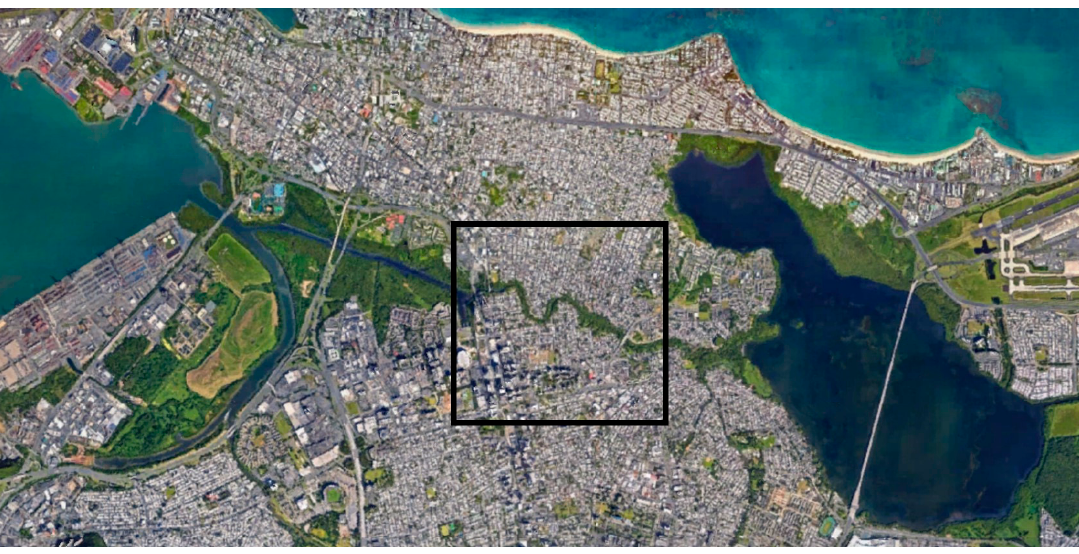
Figure 1. Satellite image [12] of area surrounding Martin Peña District of Puerto Rico, with the three urban community gardens located in the region in the black border.